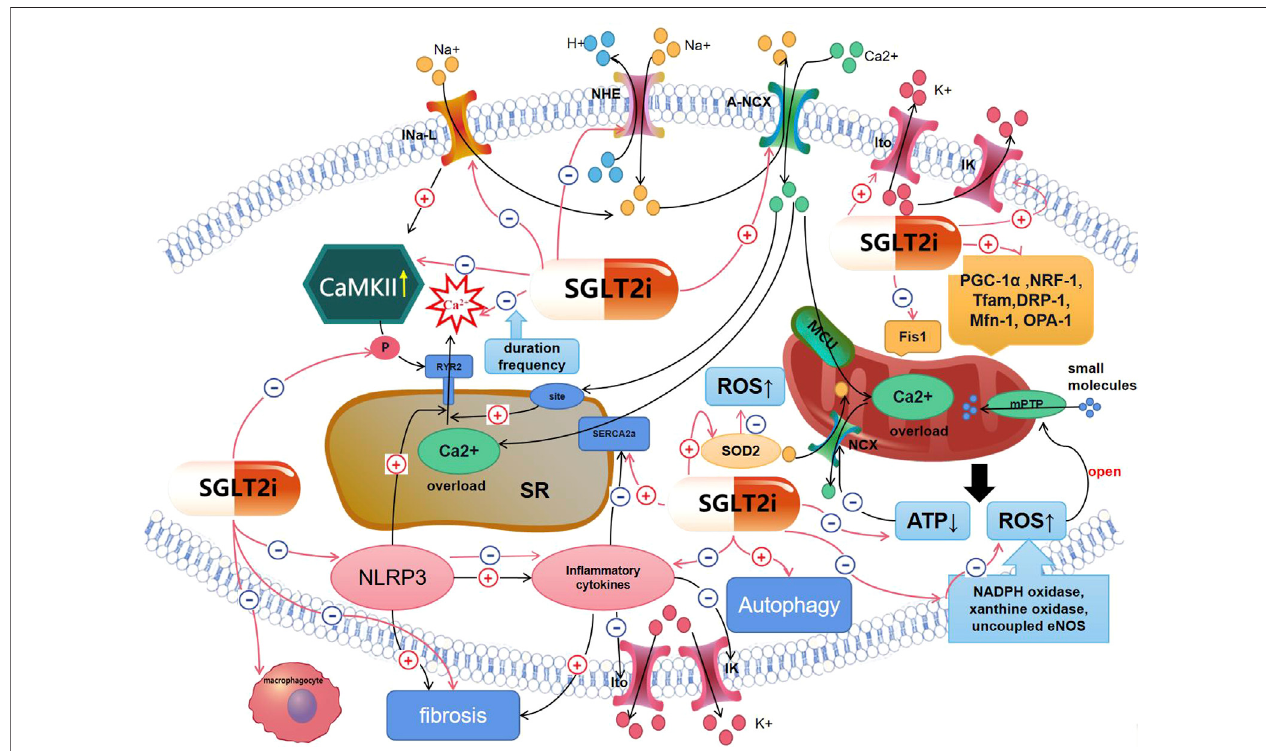
FIGURE1| MechanismsofSGLT2is ′ effectonarrhythmias.RedlinesrepresenttheeffectofSGLT2i;blacklinesmeanmechanismsofarrhythmias.(1)SGLT2iscan affect cardiomyocytes ’ electrical remodeling, including inhibiting I Na-Late , NHE , Ca 2+ spark, the decreasing of ATP, RYR2 phosphorylation, CaMKII activity, in fl ammatory cytokines; increasing Ito, IK, SERCA2a activity, so that intracellular Na + and Ca 2+ overload and the disorder of K + currents could be ameliorated. (2)SGLT2is can ameliorate arrhythmiasby inhibitingmyocardial in fl ammation and structuralremodeling, including inhibiting NLRP3 , in fl ammatory cytokines and fi brosis, so that K + currents ’ disorder can be improved. (3)SGLT2is can ameliorate arrhythmias by improving mitochondrial dysfunction and oxidative stress, including promoting mitochondrial biogenesis; inhibiting the decreasing of ATP, the increasing of ROS, so that intracellular ions administration can be improved. (4)SGLT2is can ameliorate arrhythmias by ameliorating